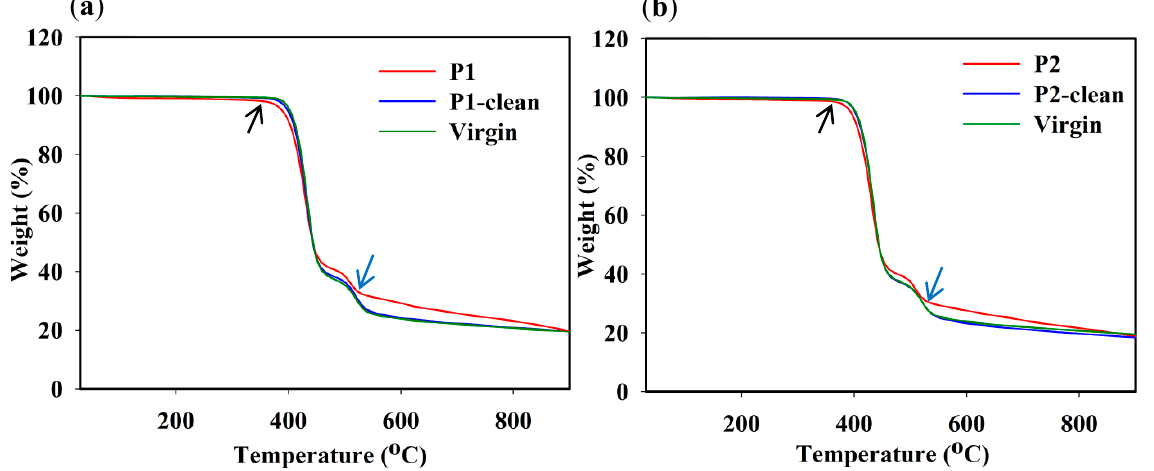
Figure 8. A comparison of TGA graphs for ( a ) P1 fouled, P1-clean, and virgin membrane and ( b ) P2 fouled, P2-clean, and virgin membrane.